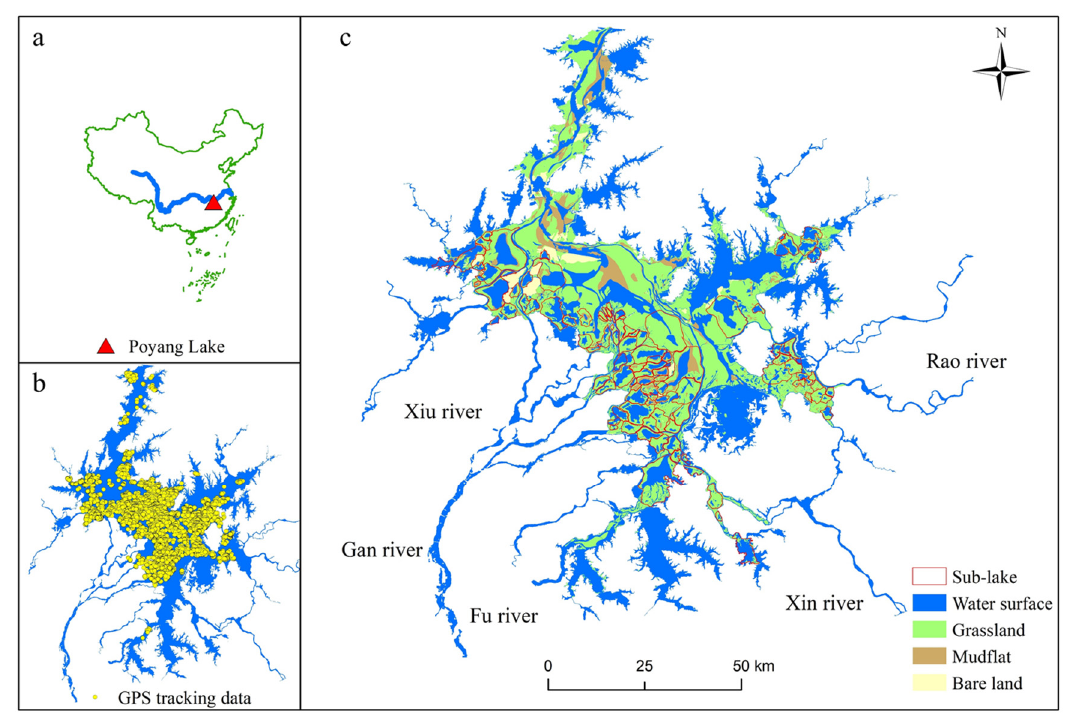
Figure 1. ( a ) Location of the study area. ( b ) GPS tracking data in Poyang Lake. ( c ) The land use/cover was interpreted from Sentinel-2 in the winter of 2019.